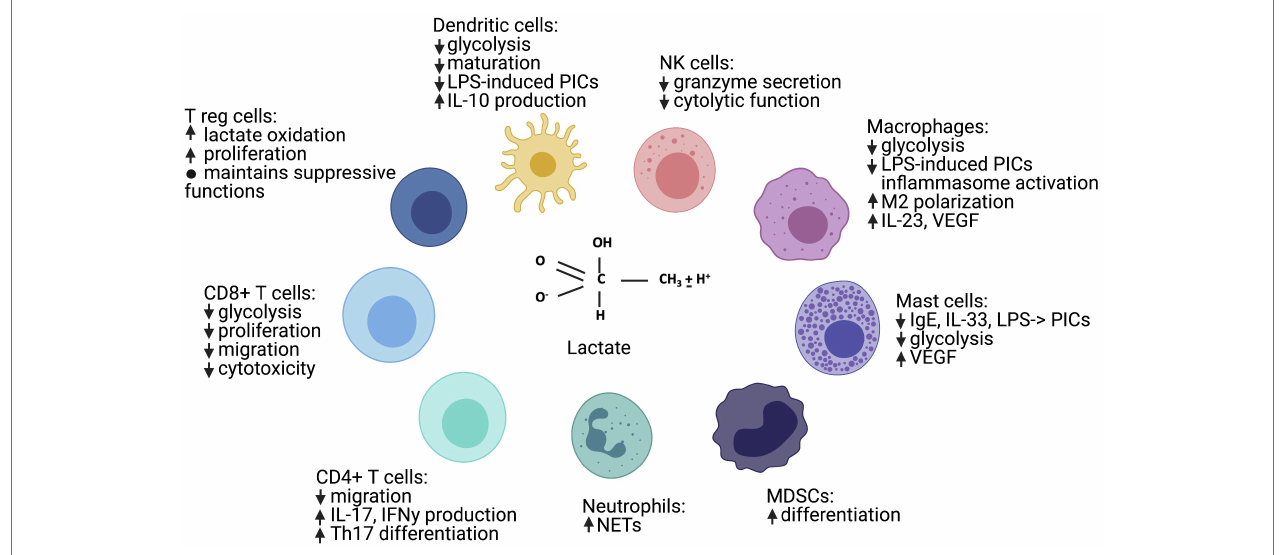
FIGURE 2 | Lactate has many immune cell-specific effects, ranging from general immunosuppression to Th17 and M2 polarization. “ ⭡ ” indicates a positive signal or induction, “ ” indicates a negative signal or inhibition, and “PICs” indicates “pro-inflammatory cytokines.” Figure created with ⭣